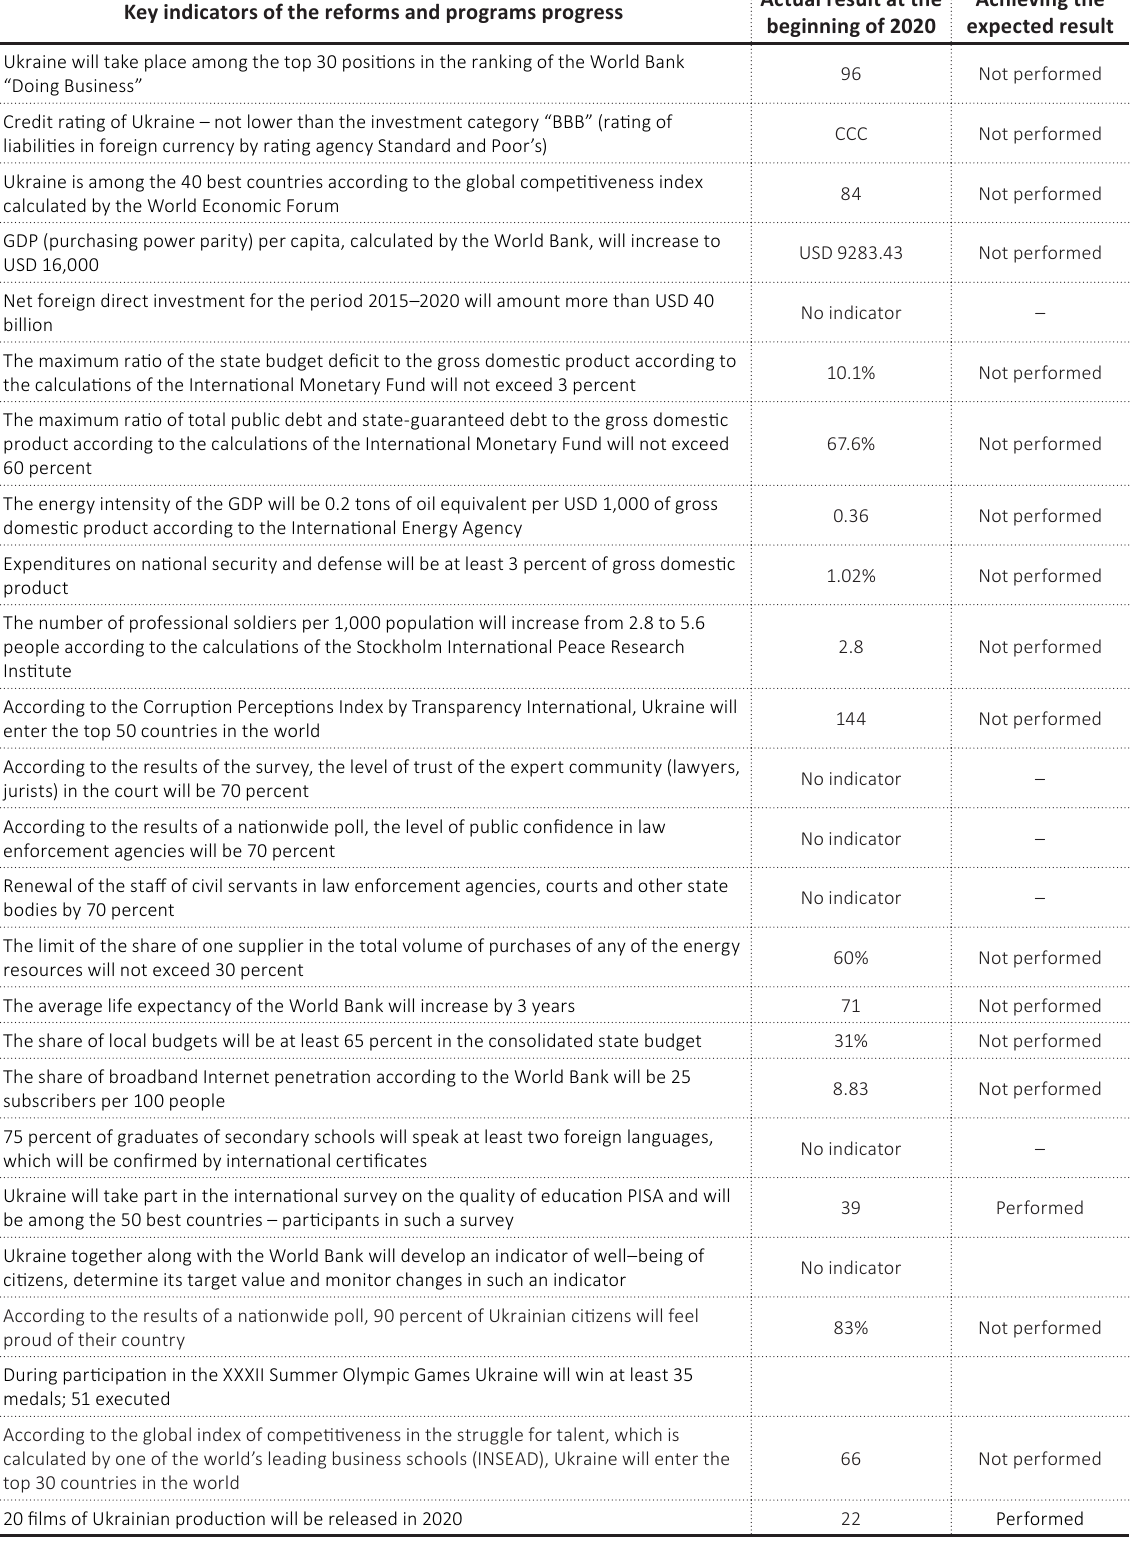
Table 1. Key indicators for assessing the implementation of the Sustainable Development Strategy “Ukraine –